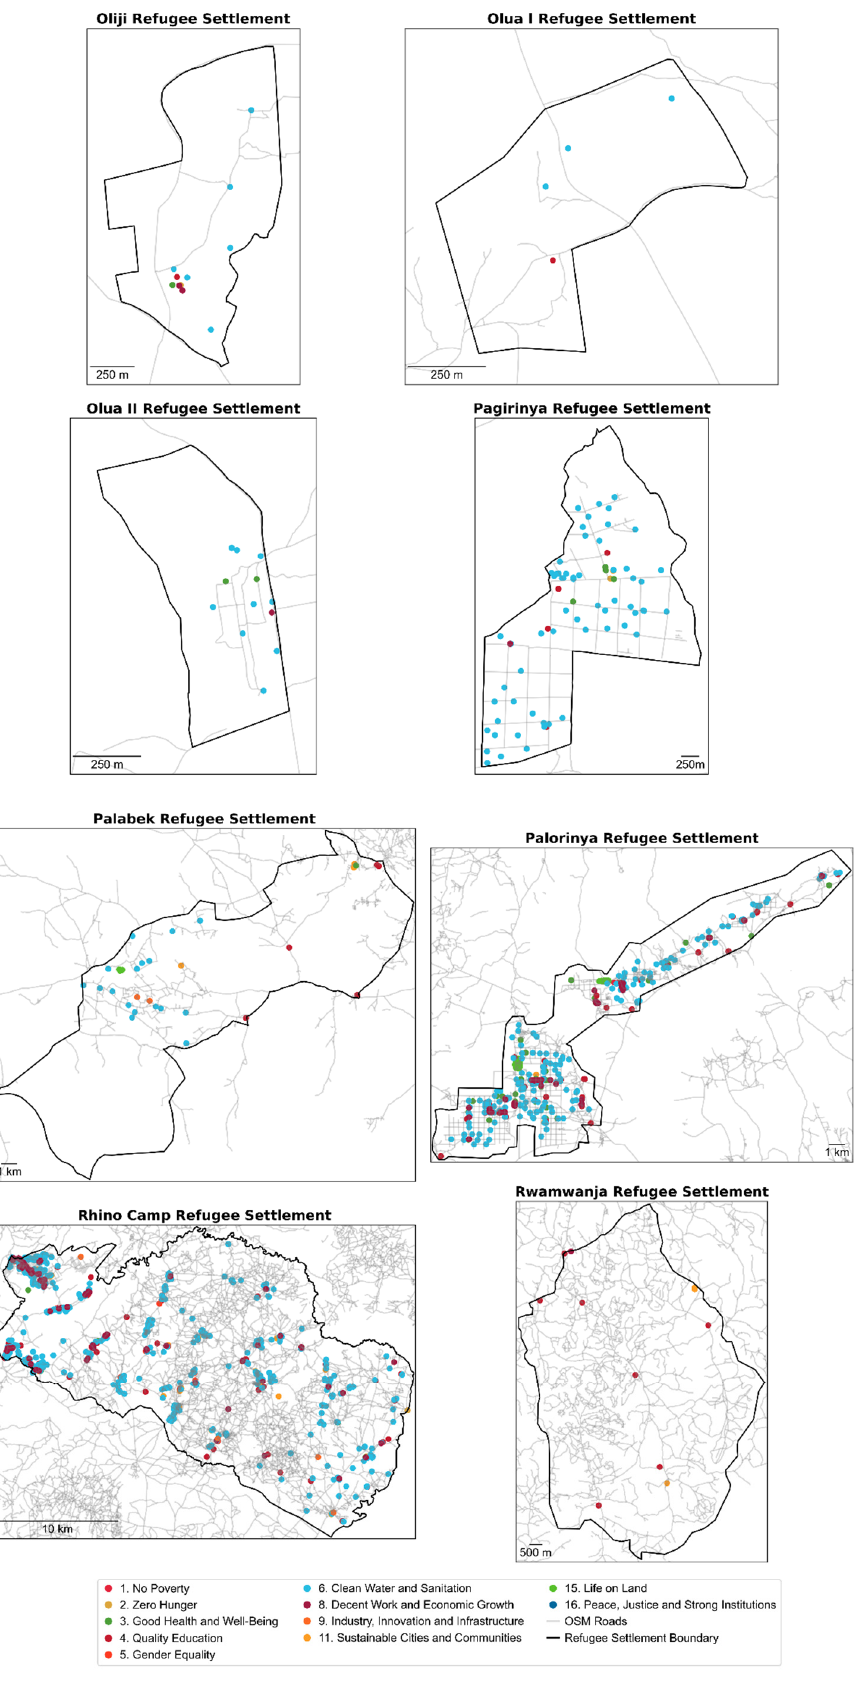
Figure A1. Maps of SDG-relevant OSM feature distribution, OSM roads, and building footprints and settlement boundaries across 28 study refugee settlements. Note the differing cartographic scale between settlement